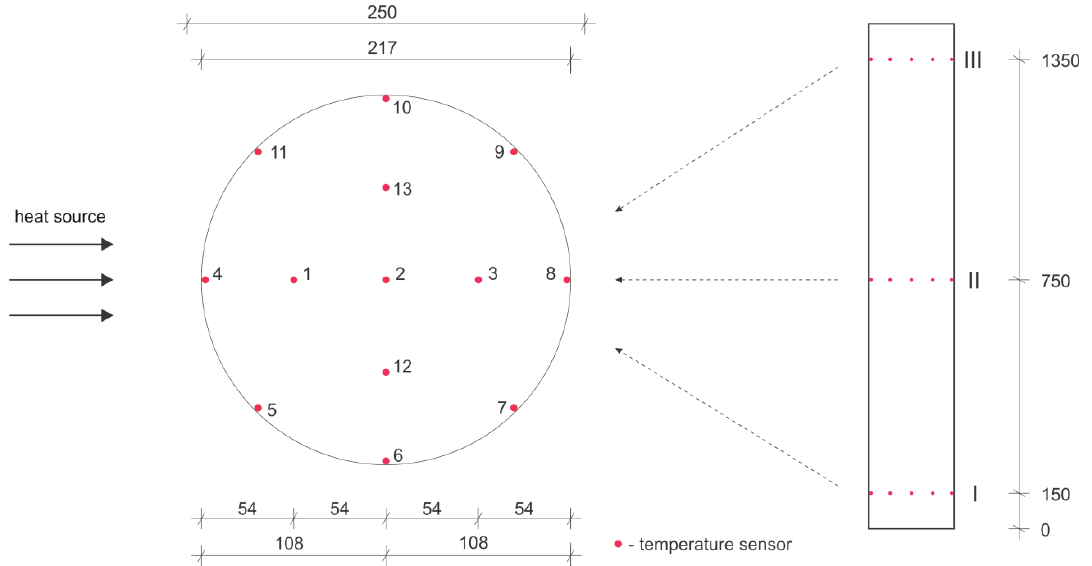
Figure 8. The position of the temperature sensors within the reinforced concrete pillar, cross-section ( left ) and longitudinal cross-section ( right ).